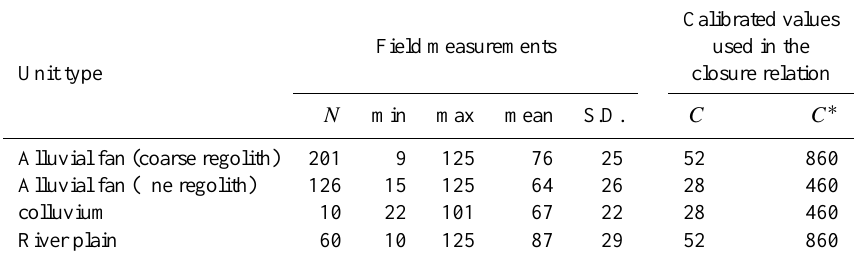
Table 3. Comparison of saturated hydraulic conductivity ( K s ; mmh − 1 ) values observed in the study area and the calibrated values used in the closure relation C and C ∗ .